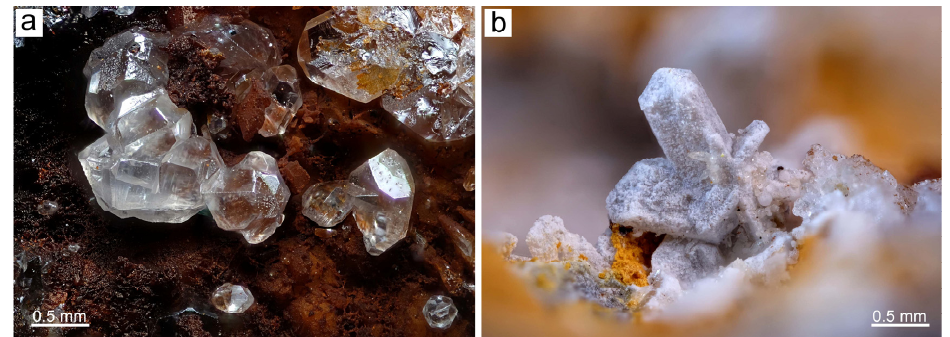
Figure 5. Optical images of cerussite from the Mastricarro Barite Mine (Catanzaro, southern Italy): ( a ) aggregates of prismatic colourless cerussite crystals; ( b ) V-twinned cerussite. Under SEM, the cerussite crystals appeared to lack a regular morphology, and showed the formation of block aggregates (Figure 6). An EDS semi-quantitative analysis performed on the cerussite crystal (Figure 6) highlighted a chemical composition made of 80.2 wt% PbO and 17.5 wt% CO 2 , in accordance with data from the literature [27,33].